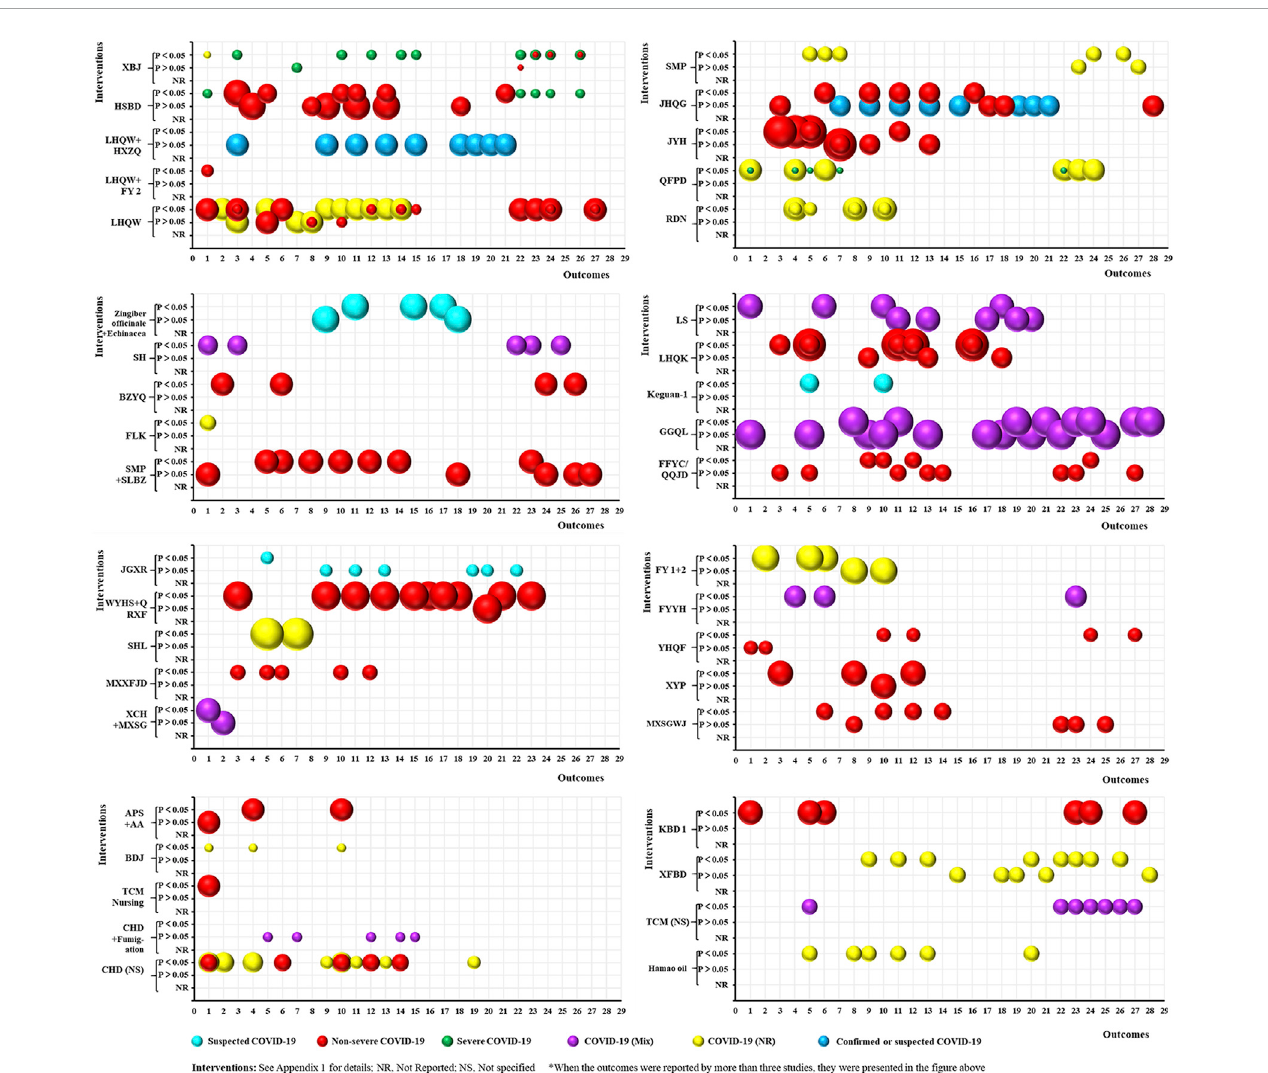
FIGURE 4 Evidence mapping of traditional Chinese medicine (TCM) interventions in coronavirus disease (COVID-19) treatment RCTs. Outcome codes: Total Effective Rate(1);Clinical curerate(2);Diseaseaggravationrate(3);Durationofhospitalization (4);ChestCTmanifestations(5);TCMsyndromescore (6);Viral nucleicacidnegativeconversionrate(7);Timetoviralassayconversion(8);Feverrecoveryrate(9);Timetofeverrecovery(10);Coughrecoveryrate(11);Time to cough recovery (12); Fatigue recovery rate (13); Time to fatigue recovery (14); Rate of shortness of breath recovery (15); Sputum disappearance rate (16); Rate of muscle pain disappearance (17); Rate of sore throat disappearance (18); Diarrhea disappearance rate (19); Anorexia disappearance rate (20); Rate of chest tightness disappearance (21); In fl ammatory biomarkers: WBC (22), LYM (23), CRP (24), NEU (25), ESR (26), and PCT (27); and Nausea/vomiting disappearance rate